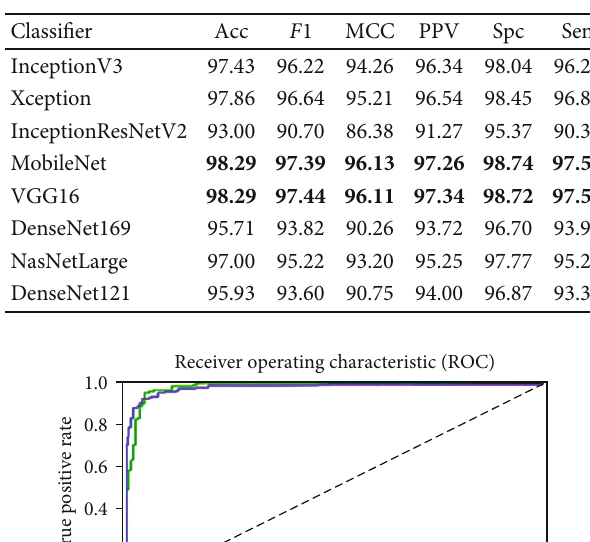
Figure 4: Accuracy versus convolutional blocks and standard deviation of each experiment. Table 4: Parameters of di ff erent classi fi cation models for all classes with the best value in bold (%).